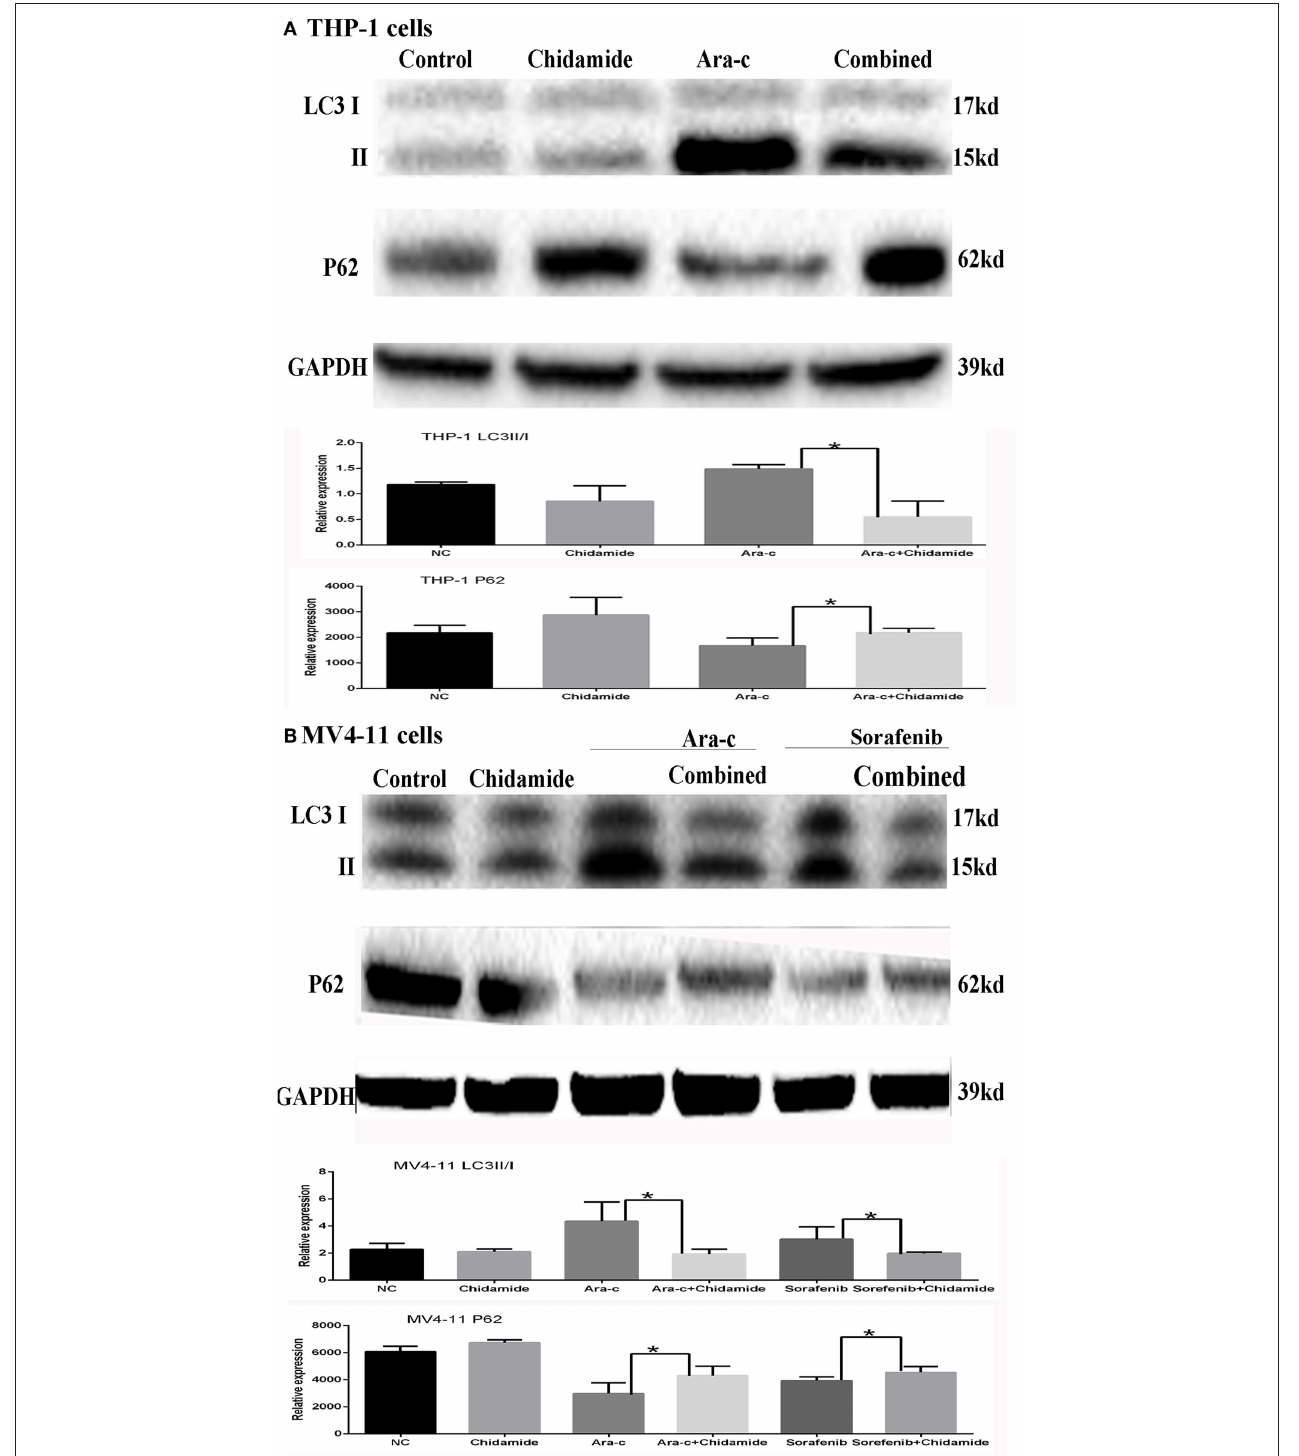
FIGURE 4 | Effect of chidamide on the autophagy level in drug-treated acute myeloid leukemia (AML) cells. Western blot analysis of the p62 protein levels and ratio of LC3II/LC3I in AML cells treated with Ara-c or sorafenib alone or in combination with chidamide, and co-treatment of chidamide with Ara-c or sorafenib in AML cells, the level of p62 protein increased, and the ratio of LC3II/LC3I decreased, indicating that chidamide inhibited the Ara-c- or sorafenib-induced level of autophagy in AML cells. (A) The level of p62 protein increased and the ratio of LC3II/LC3I decreased, indicating that chidamide inhibited the Ara-c induced level of autophagy in THP-1 cells. (B) The level of p62 protein increased and the ratio of LC3II/LC3I decreased, indicating that chidamide inhibited the Ara-c or sorafenib-induced level of autophagy in MV4-11 cells. * p < 0.05.